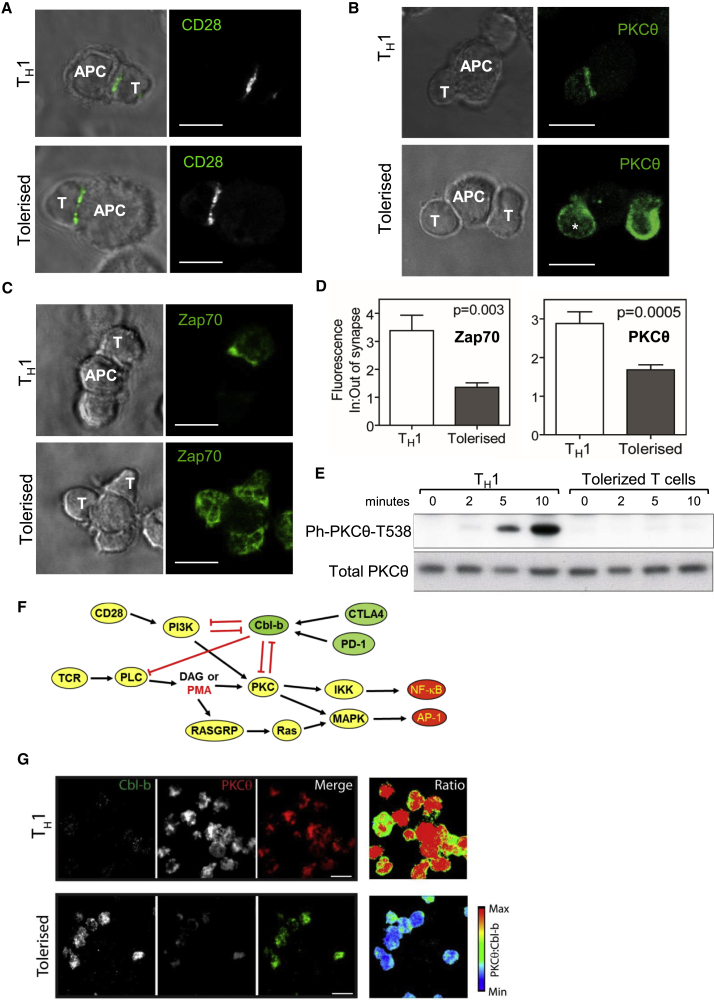
Altered Immunological Synapse Morphology and Reduced TCR-Proximal Signaling in Tolerant T CellsT cells were tolerized by either intra-nasal (IN) delivery of peptides (A–E and G) or sub-cutaneous injection of peptides (F).(A–C) Confocal microscopy of Th1-like cells or IN-tolerized T cells coupled with bone marrow APCs presenting cognate peptide for 10 min and imaged by immunofluorescence confocal microscopy following immune-labeling for (A) CD28, (B) PKCθ, or (C) Zap70.(D) Quantification of confocal microscopy images showing mean enrichment of PKCθ and Zap70 at the T cell-APC interface as in (B) and (C). Values were derived from at least three biological replicates. p values were calculated by Mann-Whitney test, error bars are SEM.(E) Western blot analyses of PKCθ T538 phosphorylation in Tg4 Th1 or IN-tolerant T cells following activation with cross-linked anti-CD3/CD28 for the indicated amounts of time.(F) Model depicting TCR and CD28 signaling pathways that can be antagonized when Cbl-b is activated by CTLA4 or PD-1, or bypassed by PMA.(G) TIRF microscopy of Cbl-b and PKCθ enrichment at the T cell immunological synapse in Th1-like cells or tolerized T cells.Scale bars: 10 μM.